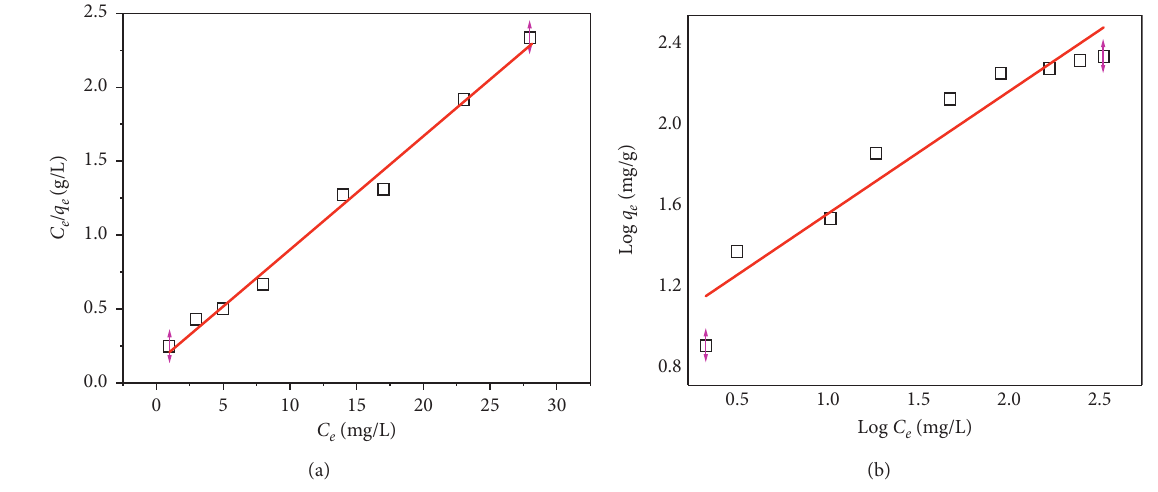
Figure 5: (a) Langmuir and (b) Freundlich plots on As(V) adsorption using FAC. Table 4: The Langmuir and Freundlich model parameters.